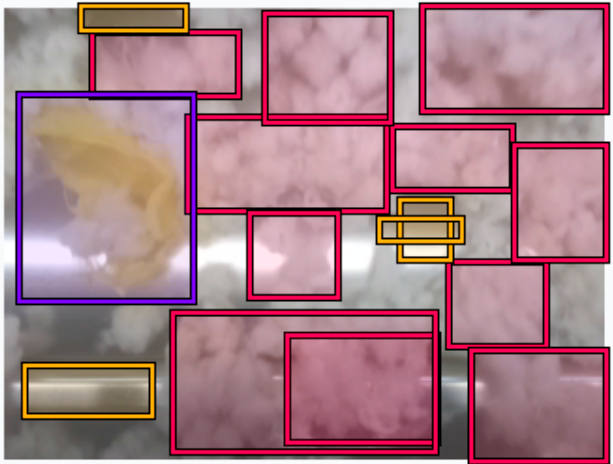
Figure 4. Deep learning annotated image, with each colored bounding-box representing a different class object. This annotated image is one in the large image dataset that is included as an attachment to this technical note.